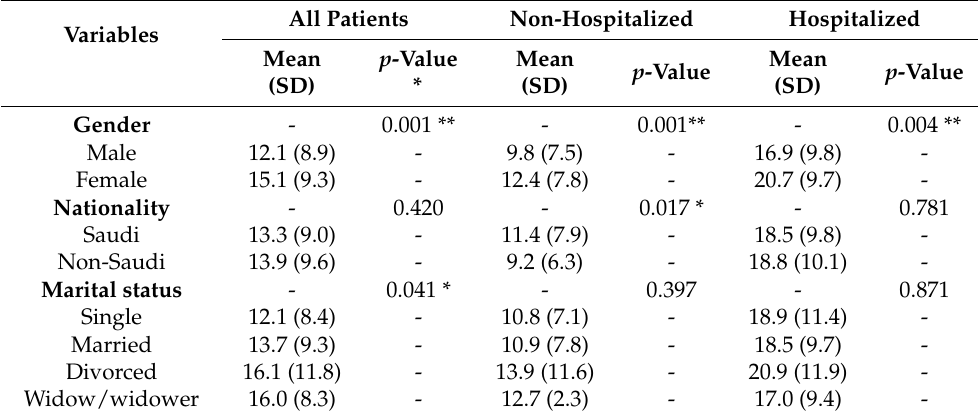
Table 5. Recovery time (days) by basic demographical characteristics of